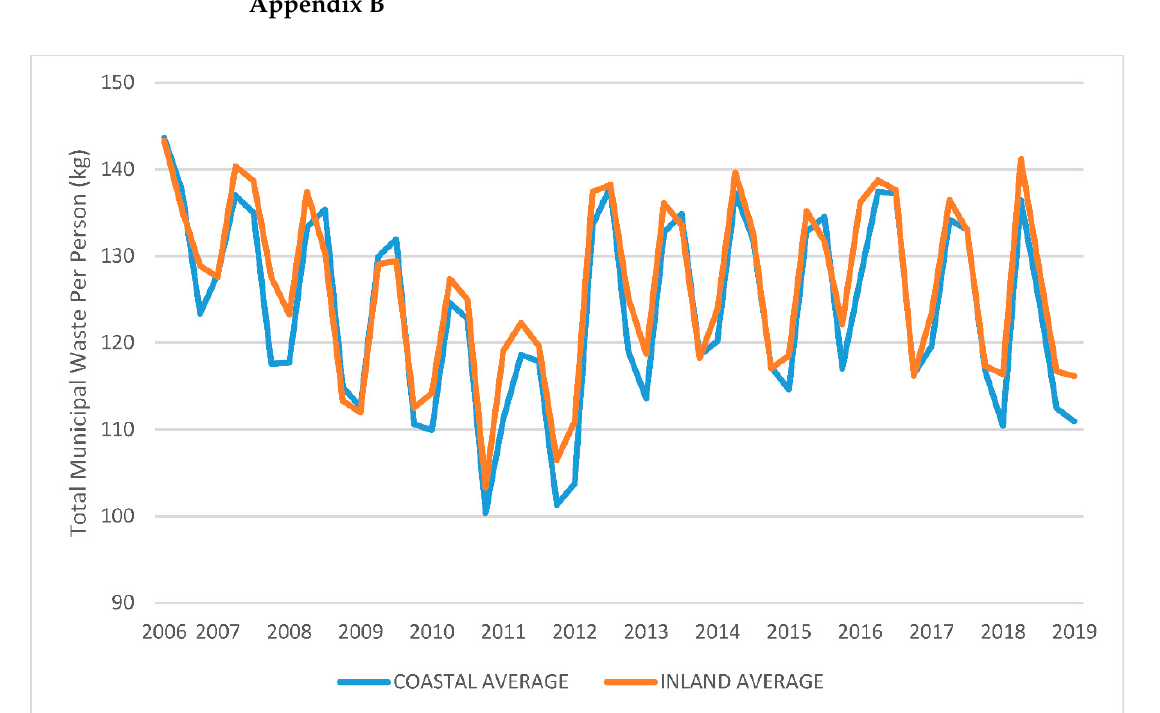
Figure A2. Total municipal waste per person for coastal and rural local authorities in Wales per quarter. Source WasteDataFlow.